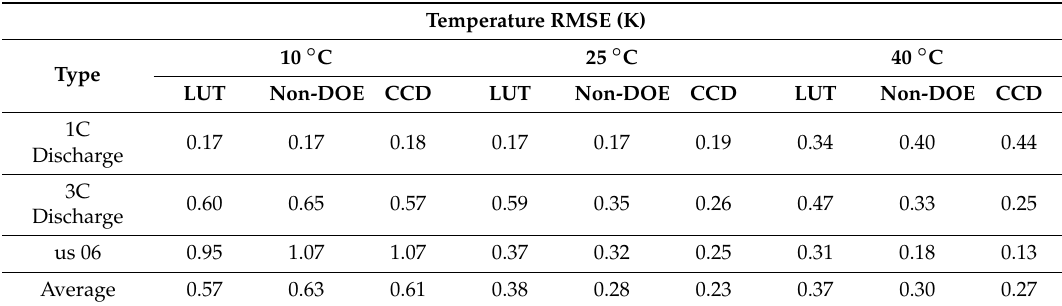
Table 6. Root mean squared error for the temperature response for LUT and Non-DOE techniques in comparison to the face-center CCD approach.